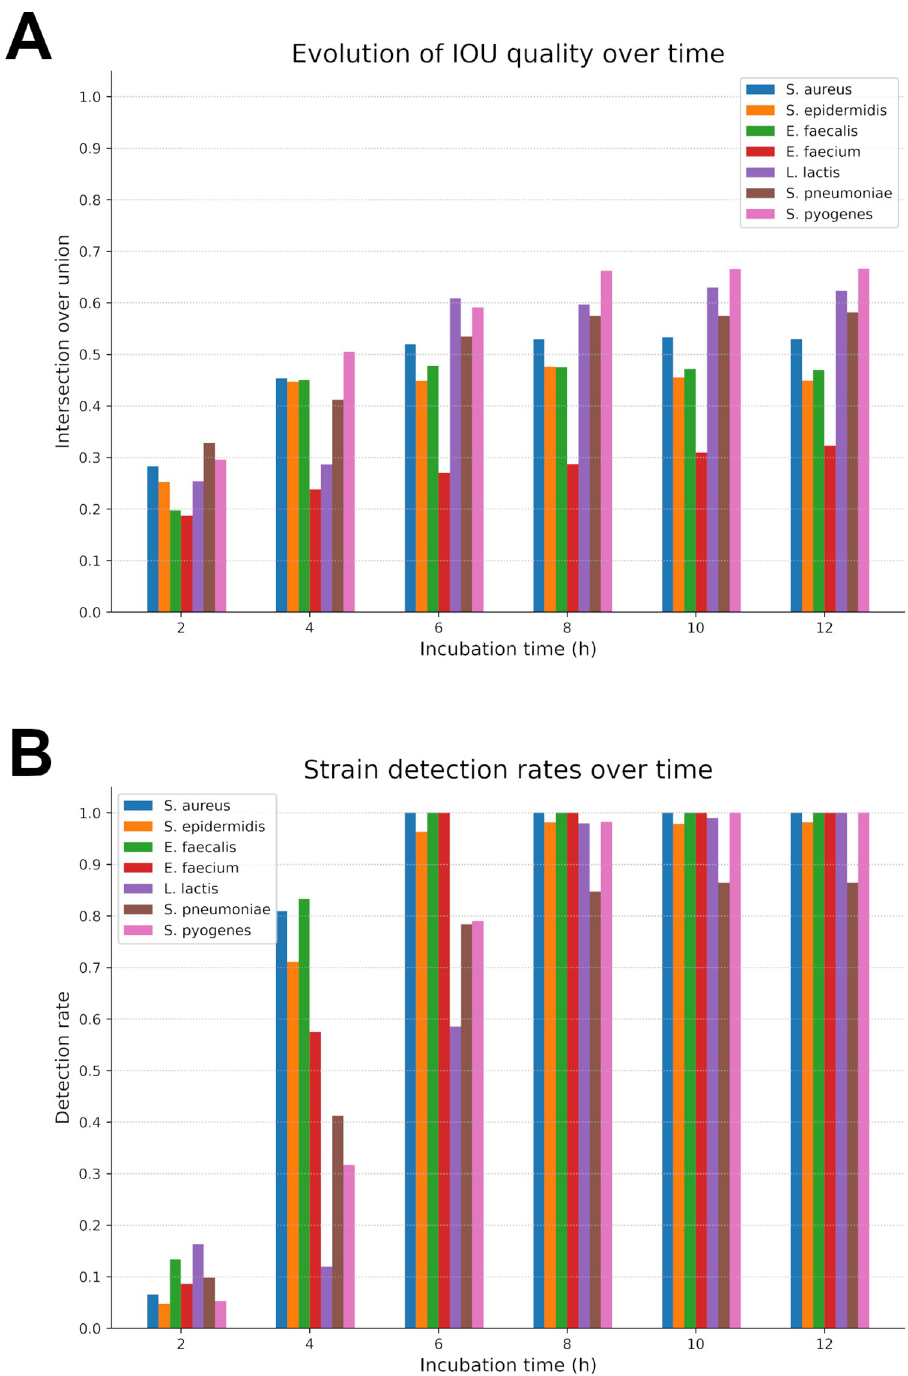
Fig 6. Detection phase results. (A) Detection rates and (B) IOU scores at four specific time marks (2, 4,6, 8,10, 12) for every strain.